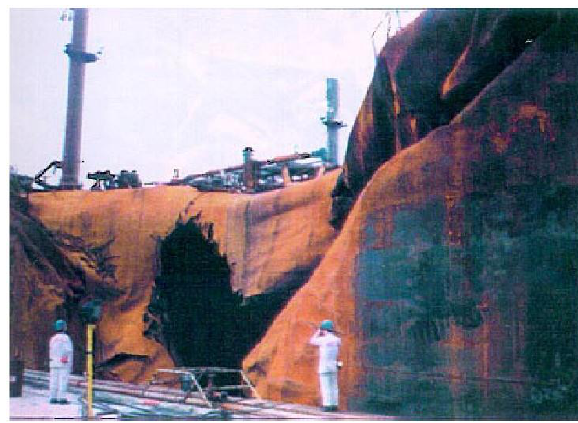
Figure 1: Damage in collision accident caused 10,000 tons oil was spilled [3].